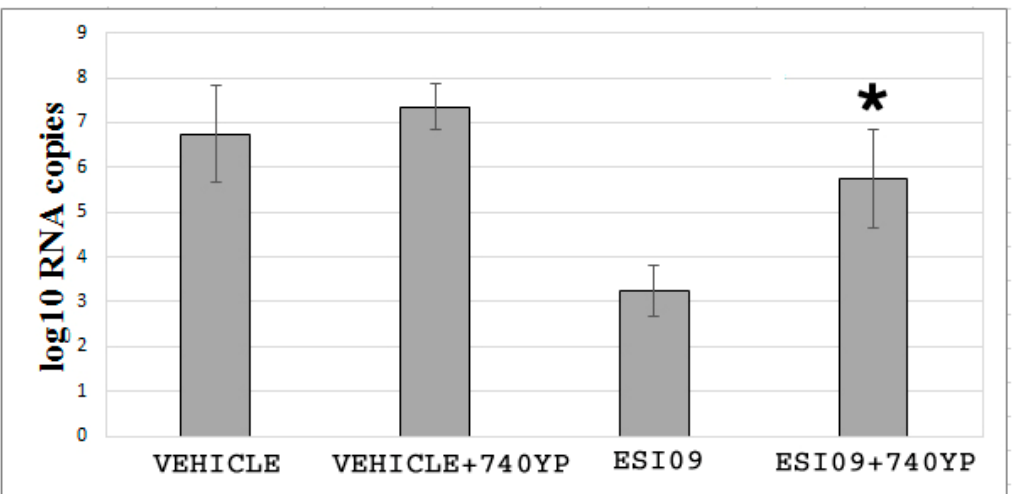
Figure 4. ESI09 regulates EBOV entry in a PI3K-dependent manner. qPCR assessment of the effects of PI3K on EPAC1-mediated EGP-VSV infection. The number of viral RNA copies detected at 1 h p.i. with EGP-VSV at an MOI of 200 in Vehicle-, Vehicle+740YP-, ESI09-, and ESI09+740YP-pretreated HUVECs. N = 3 for each group. * p < 0.05 compared to the ESI09 group.